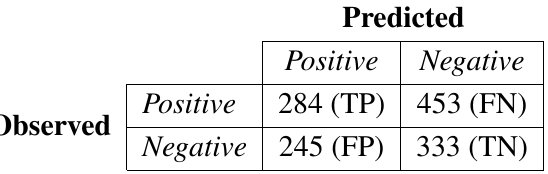
Table 1. Confusion matrix of nest detection.